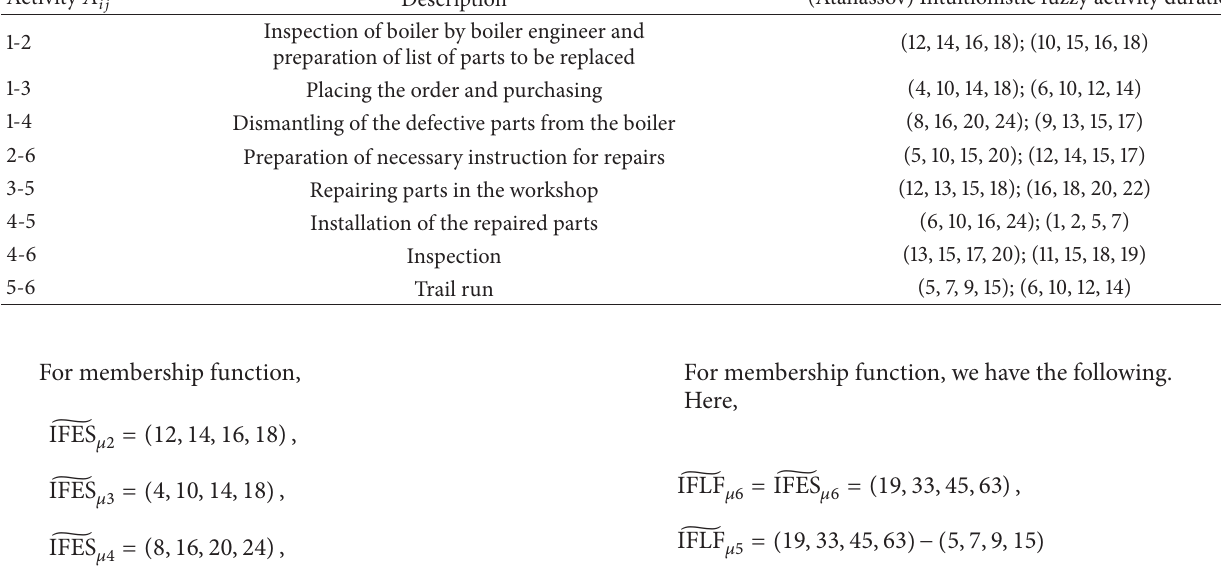
Table 1: Activity duration of each activity in an (Atanassov) intuitionistic fuzzy project network. Activity 𝐴 𝑖𝑗